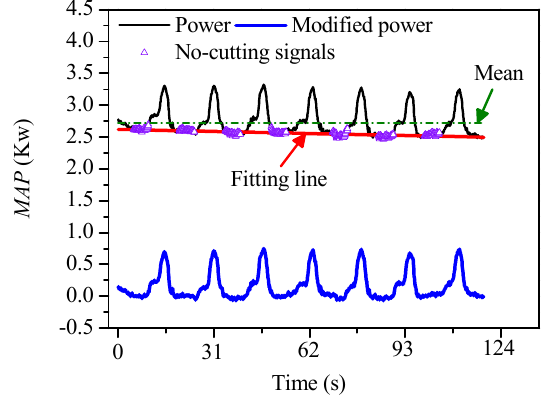
Figure 4. Data correction.